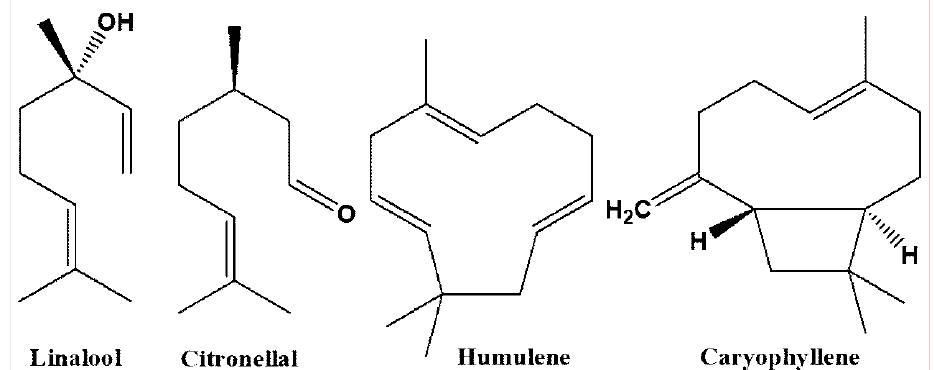
Figure 1. Chemical structures of compounds isolated from L. candidum . A computerized GC-MS (GC-6890N) equipped with a mass selective (MS)—5973 network (electron ionization 70 eV) detector from Agilent Technologies (Santa Clara, CA, USA) was used. Component recognition was performed by a comparison of the retention time index (RI) of the components to commercial standards and the samples’ mass spectrum with GC-MS libraries: Adams 2001, NIST 98, and QuadLib 1607.